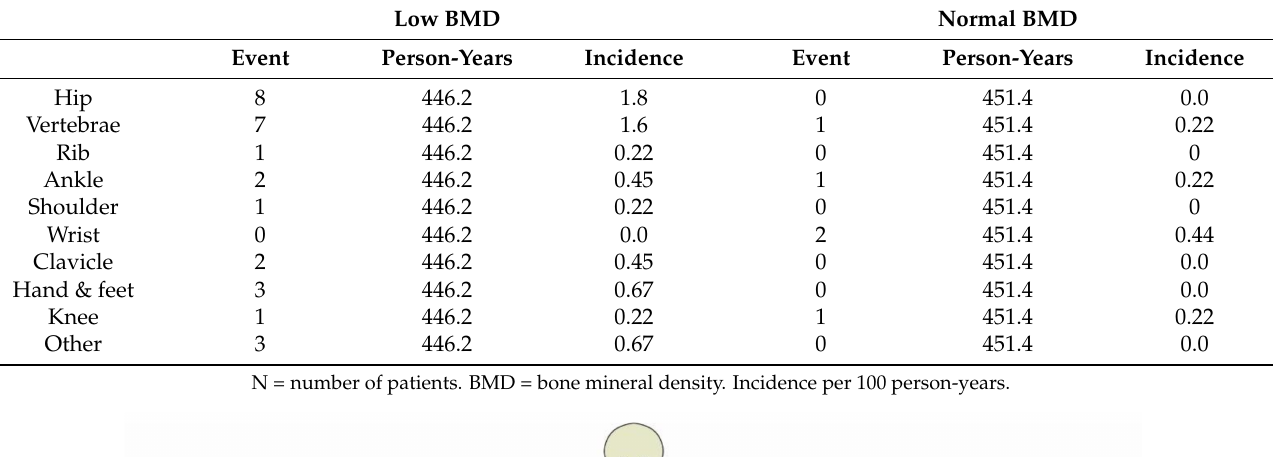
Table 3. Fracture incidence by anatomic region.